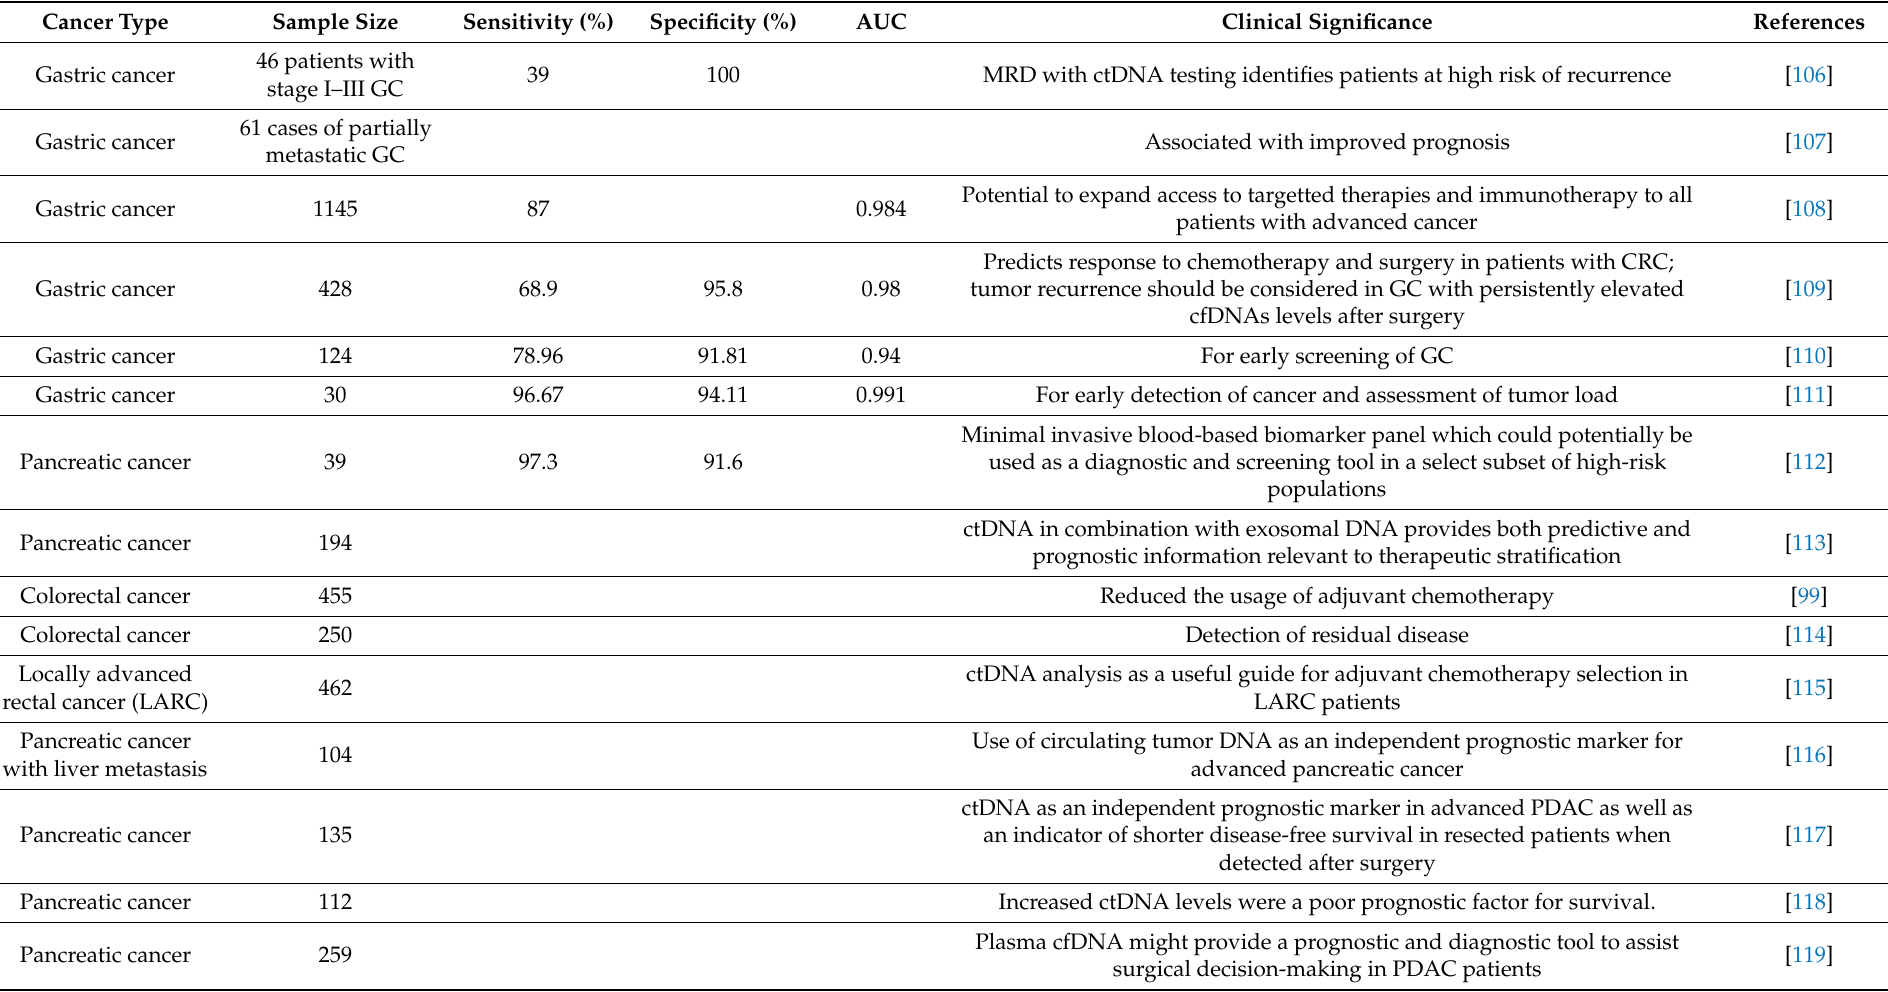
Table 2. Clinical relevance of ctDNA/cfDNA in